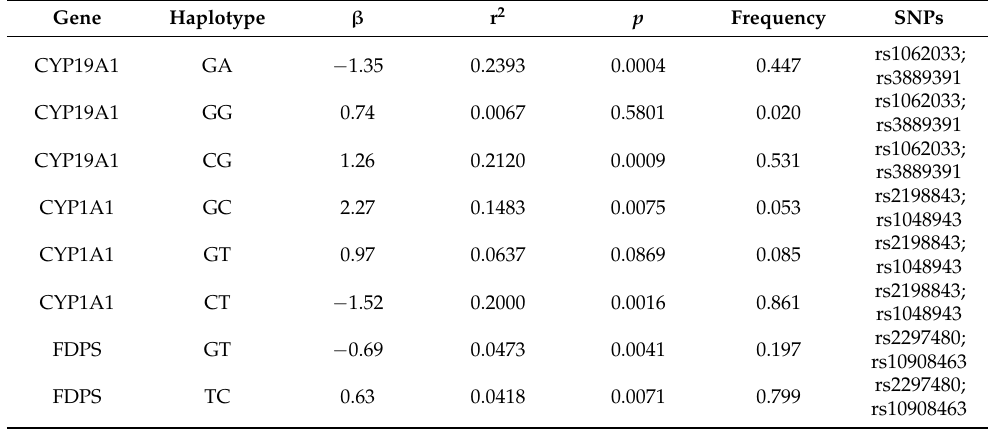
Table 4. Haplotype-based analysis of the association between genes and drug